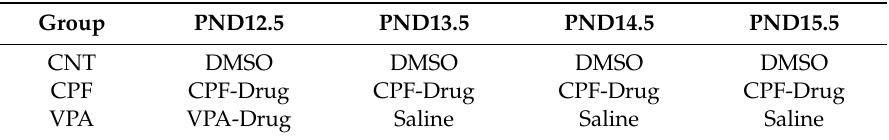
Table 1. Schedule of drug